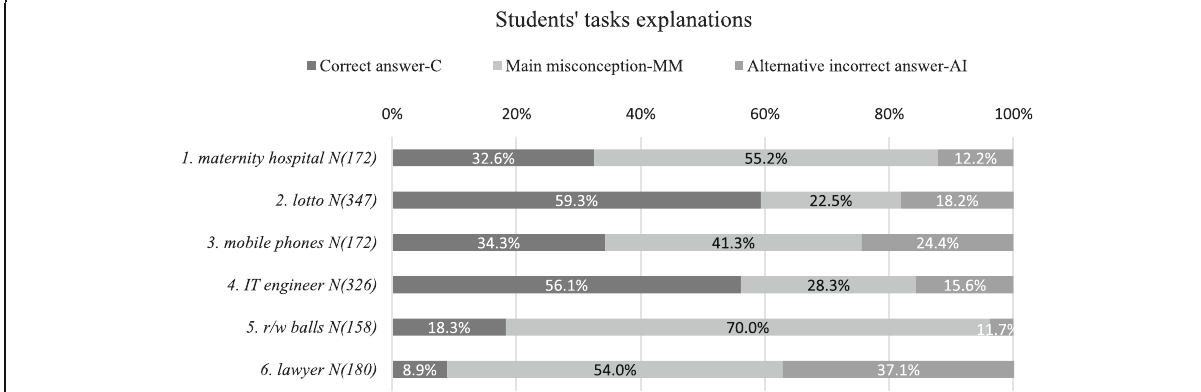
Fig. 2 Percentage of students ’ success per tasks which contains an explanation. N , number of students ’